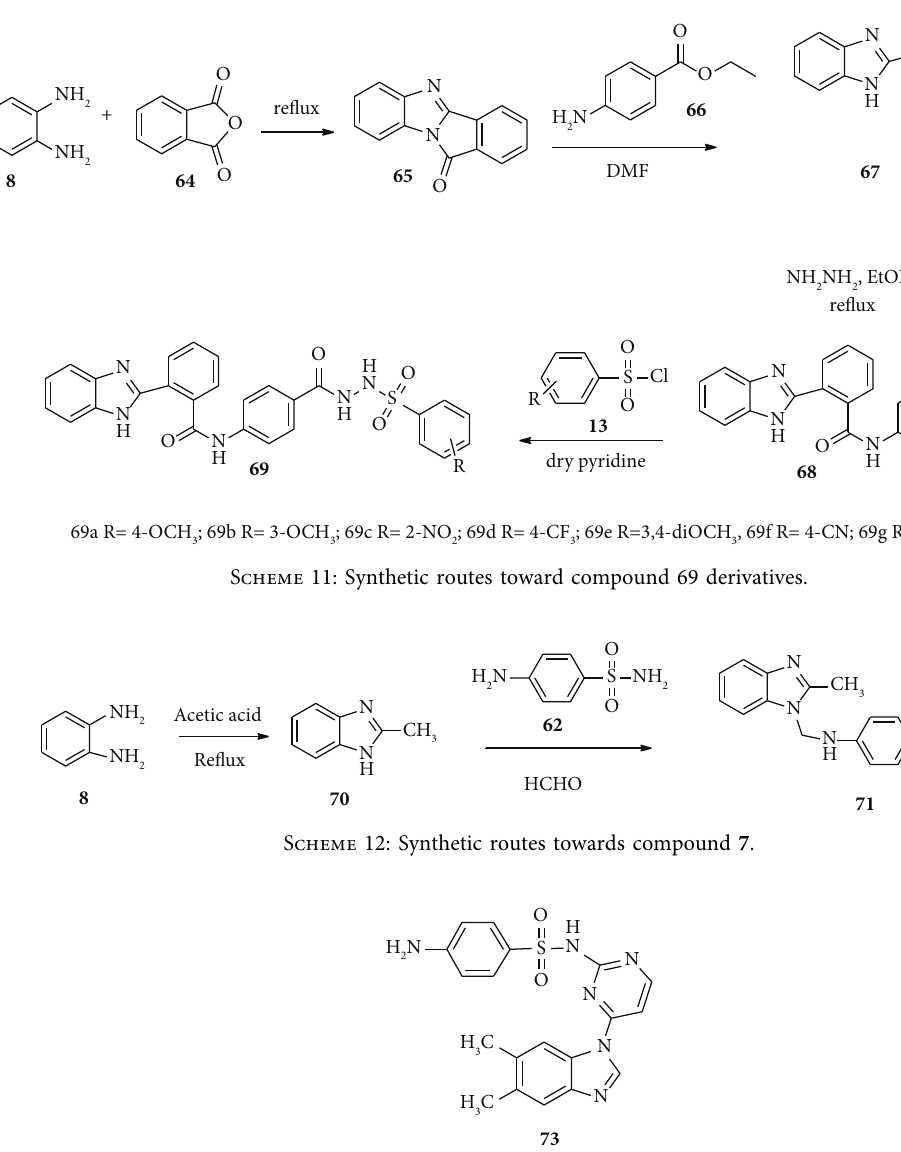
Figure 4: Chemical structures of antifungal active benzimidazole-sulfonyl